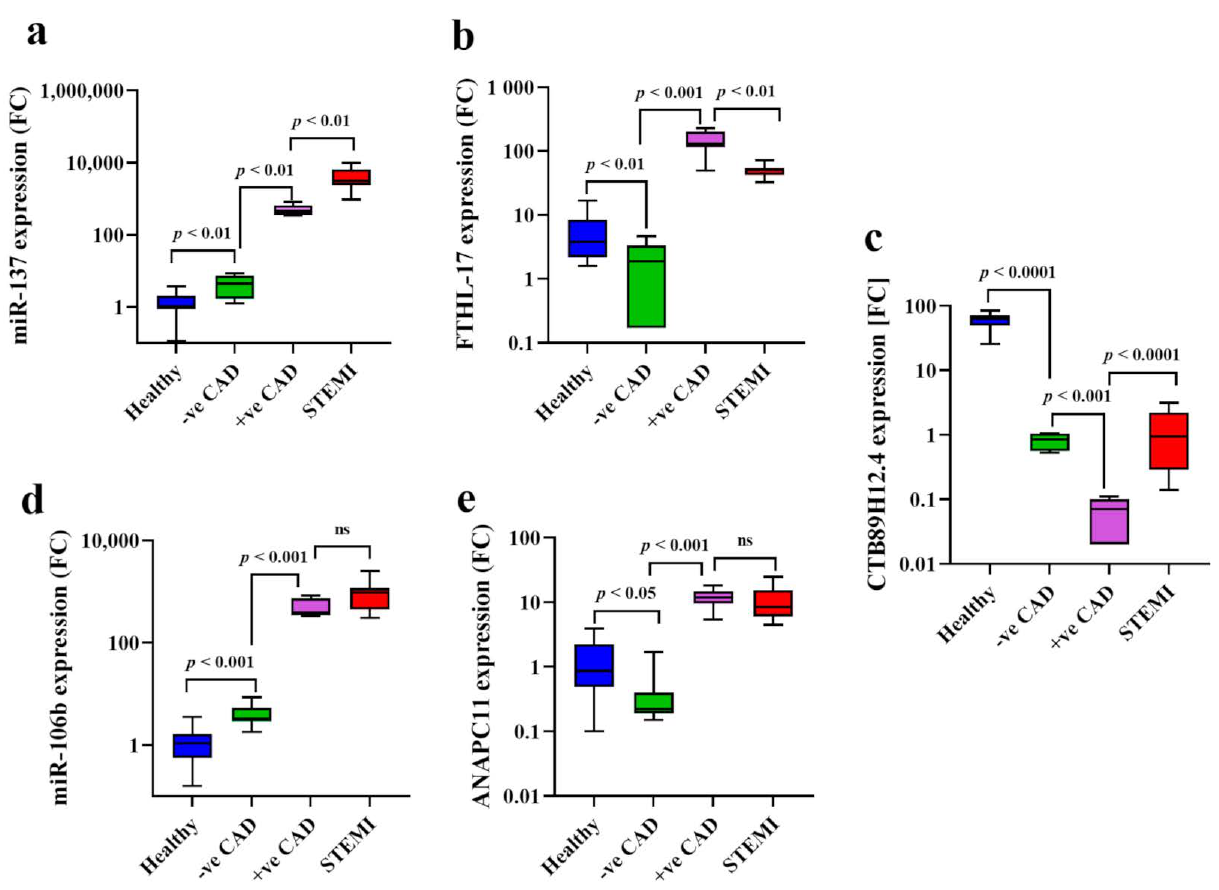
Figure 2. Boxplot graphs demonstrating the serum expression levels of miR-137 in patients with chest pain and suspected for CAD; higher expression levels of miR-137 ( a ), FTHL-17 ( b ), miR-106b ( d ) and ANAPC11 ( e ) were significantly associated with CAD; lnc-CTB89H12.4 was downregulated ( c ); Abbreviations: CAD: coronary artery disease, STEMI: ST-segment elevation myocardial infarction, FTHL-17 : Ferritin heavy chain like 17, ANAPC11 : anaphase promoting complex subunit, p < 0.05 considered significant, ns: no-significant